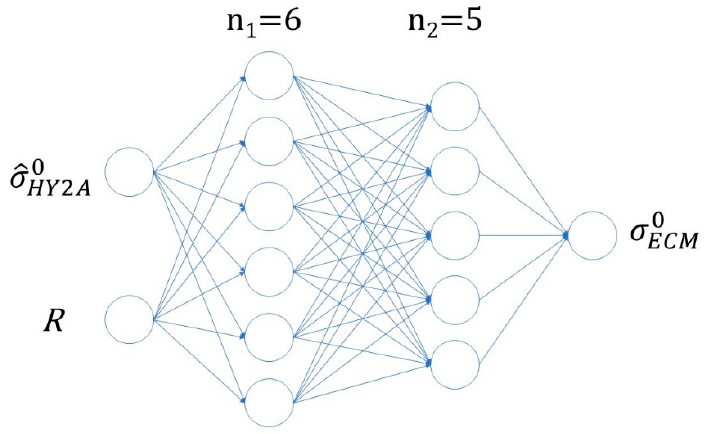
Figure 5. Schematic diagram of BP neural network topology.